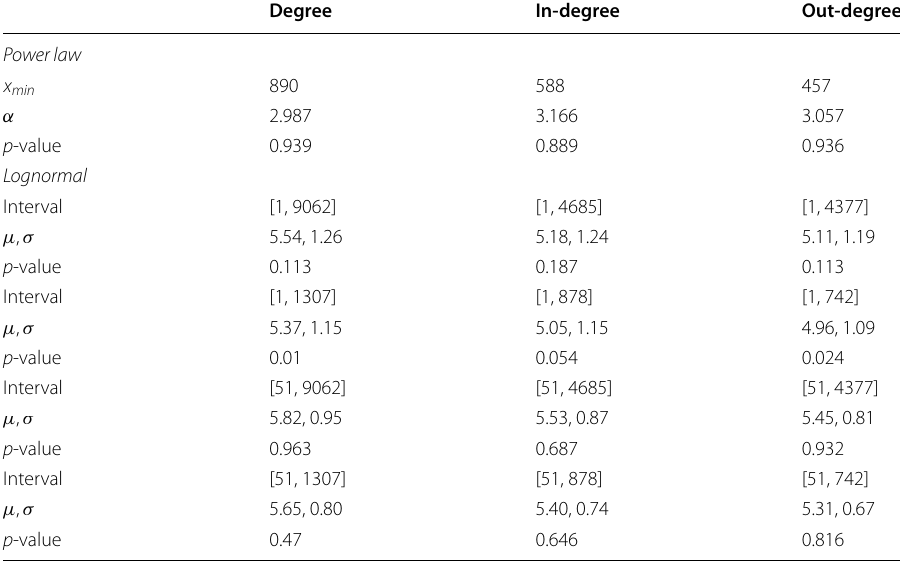
Table 4 Power-law and lognormal fittings through Kolmogorov-Smirnov test performed on